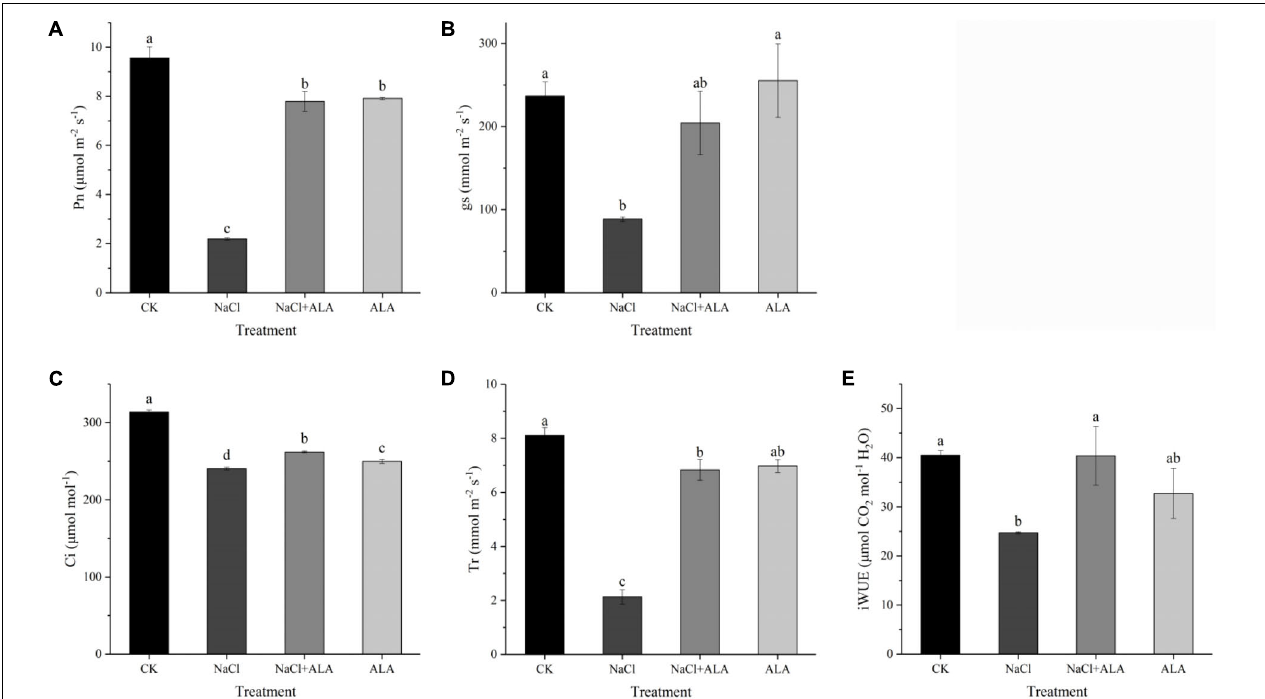
FIGURE 4 | Effects of ALA on photosynthetic gas exchange parameters under salt stress. (A) Net photosynthetic rate (Pn). (B) Stomatal conductance (gs). (C) Intercellular CO 2 concentration (Ci). (D) Transpiration rate (Tr). (E) Intrinsic water use efficiency (iWUE). The data presented were the means of 3 plants ± SE of means ( n = 3). Treatment means with different letters indicate significant differences according to Tukey’s test ( p <